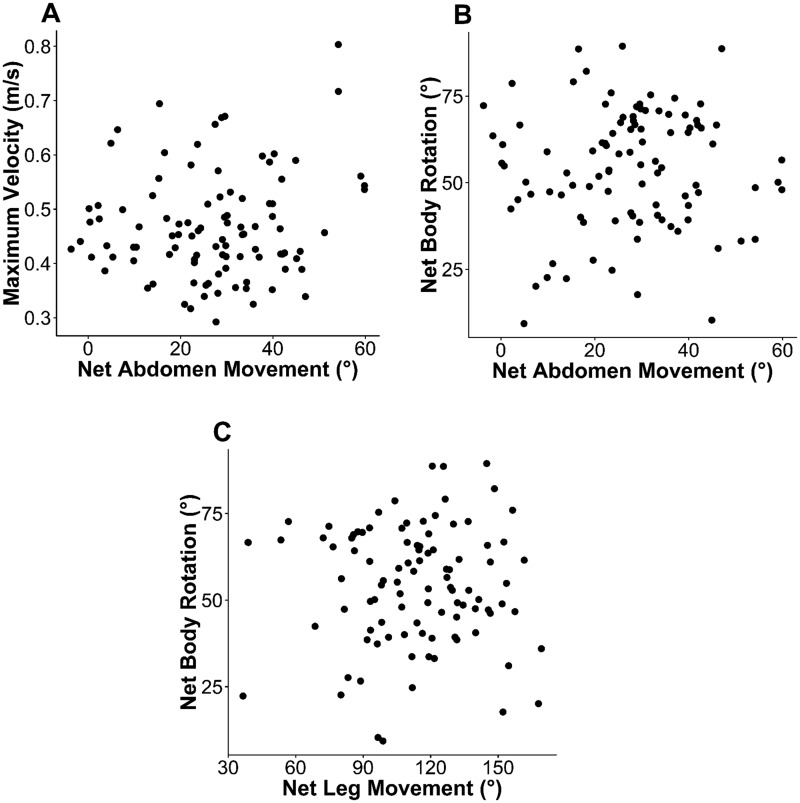
Scatterplots depicting relationships between abdominal movement, velocity, and body rotation. Each dot represents data from one unrestrained jump of G. destructor. Data are pooled for all individuals. No relationship was found to be significant (Pearson’s regression, df = 50, P > 0.05). A) Takeoff velocity versus net abdomen movement, defined as the maximum change in abdomen angle with respect to the thorax over the course of the jump; B) net body rotation, defined as the maximum change in body angle with respect to the horizontal over the course of a jump, versus net abdomen movement; and C) net body rotation versus net leg movement, defined as the maximum change in angle of the tibia with respect to the femur over the course of a jump.